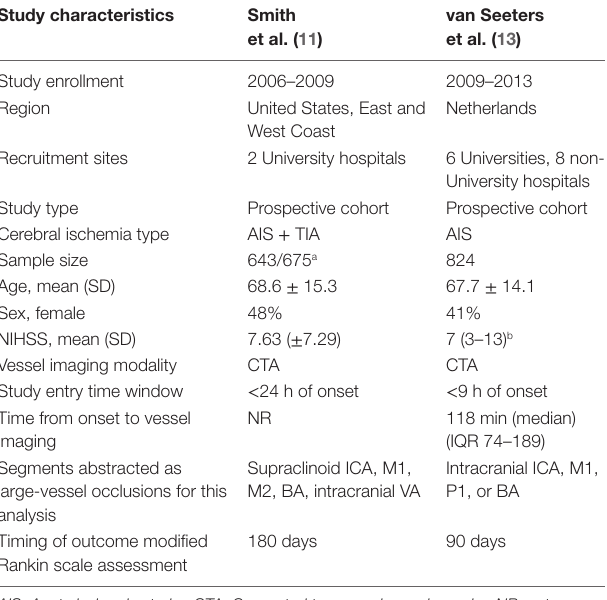
TABLe 1 | Characteristics of included